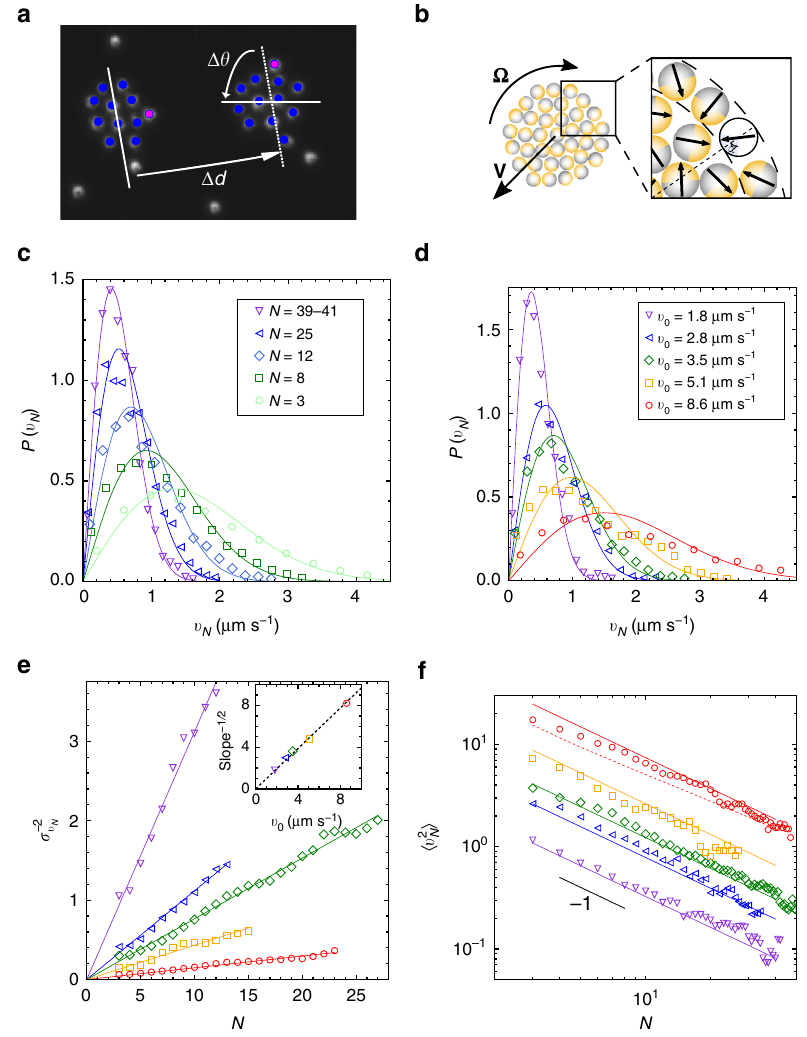
Fig. 3 Translational dynamics of individual clusters. a Two overlaid snapshots of a cluster showing its translational and rotational motions. The time interval is 10.15 s. b Sketch of the cluster model relating the colloids orientation to the global cluster velocities v and Ω : random orientation model ( α = π ) and perimeter model ( α < π ). c , d PDF for the translational velocity modulus v N of a cluster of size N , for fi xed activity v 0 = 3.1 μ m s − 1 and various cluster sizes, and for a fi xed cluster size ( N = 12) and different activities. Symbols: experimental data and solid lines: theoretical fi ts according to Eq. (8), yielding σ v Variance and mean square of translational velocity as a function of size and activity (inset). Symbols: experimental data for different activities (same as d ); solid line: random orientation model Eq. (8); dashed line: perimeter model for the highest activity v 0 = 8 μ m s −